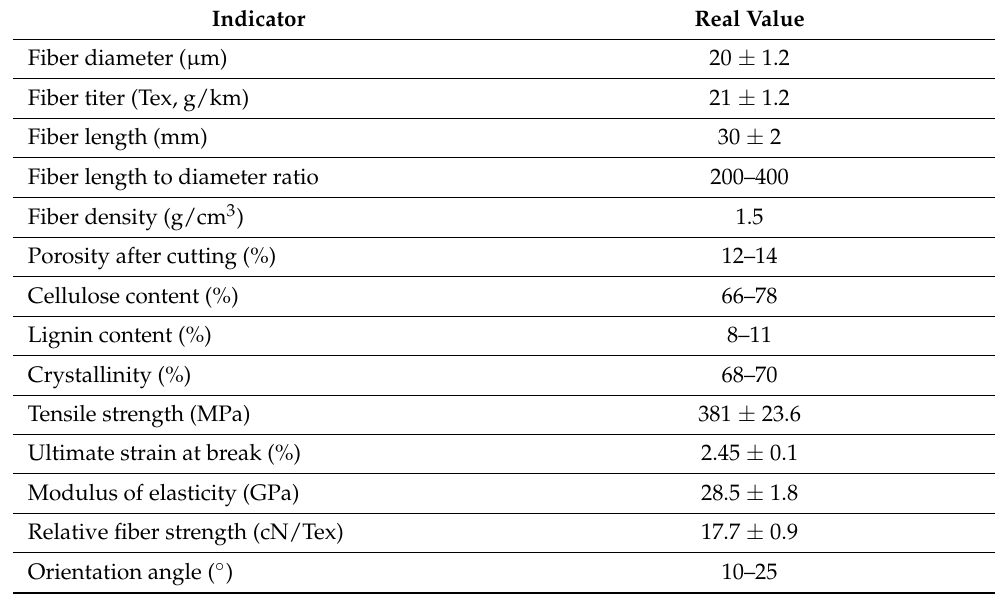
Table 2. Characteristics of sisal fiber.